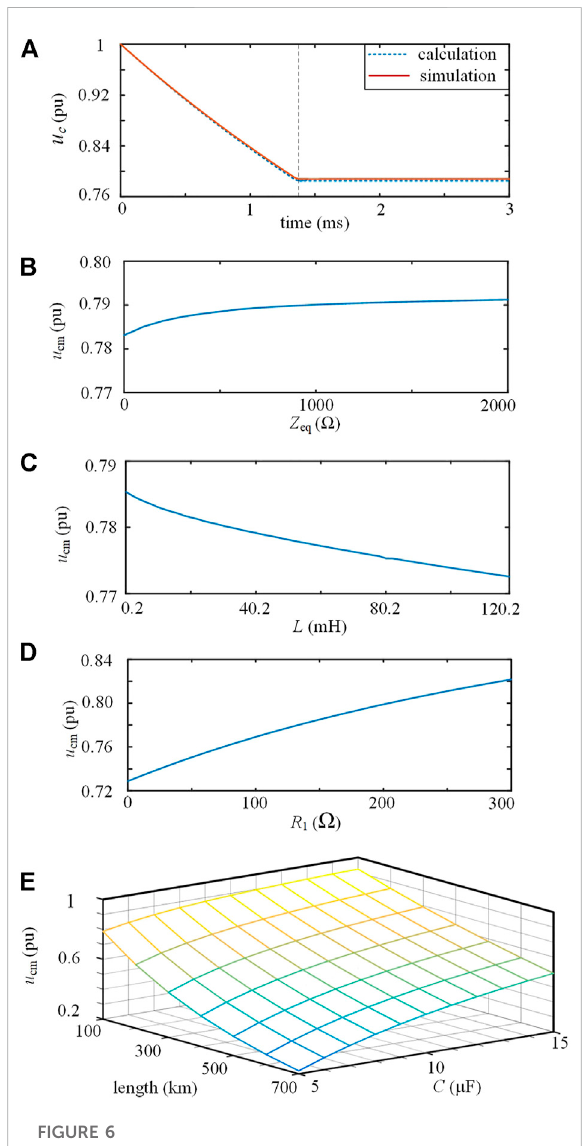
FIGURE 6 (A) Simulation and calculation values of Δ u during reclosing without fault; (B) relation between ucm and Zeq (C) relation between ucm and L (D) relation between ucm and R1 (E) relations of ucm, C and line